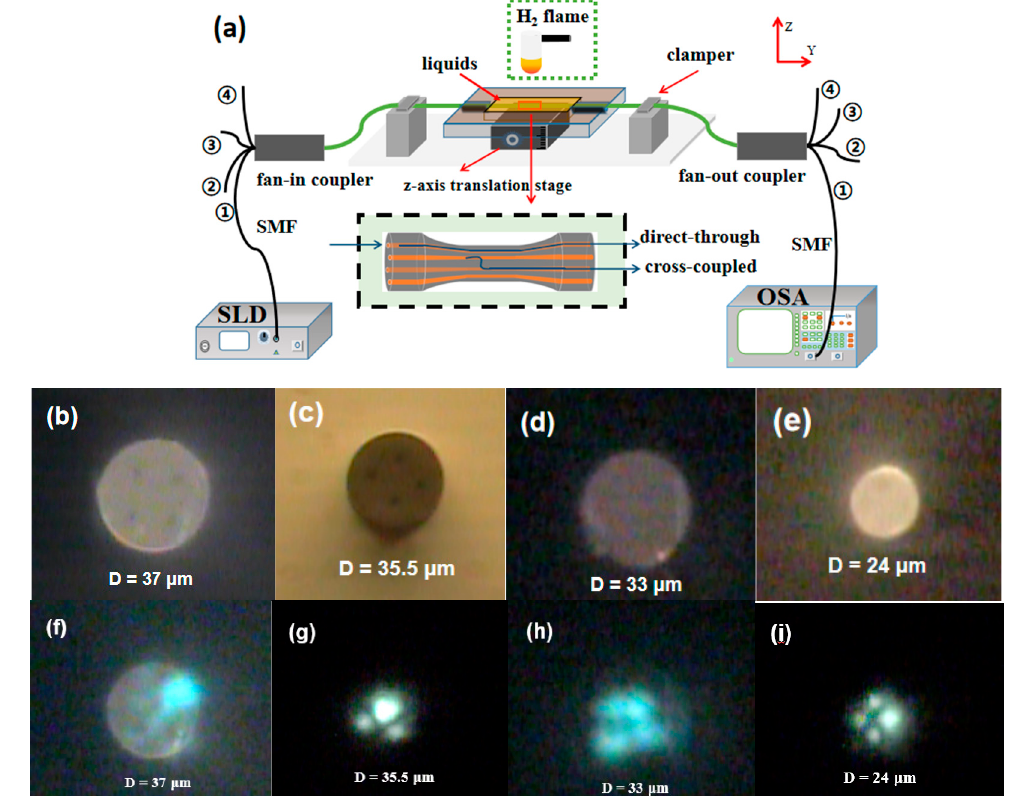
Figure 2. ( a ) Experimental set-up for fabricating TFCF RI sensors based on the vertex-core excitation scheme. Cross-sectional views of the microphotographs of the TFCF when ( b ) D = 37 μ m, ( c ) D = 35.5 μ m, ( d ) D = 33 μ m and ( e ) D = 24 μ m under a 1000× CCD microscope. ( f ) Vertex-core excitation scheme (D = 37 μ m). Far-field mode patterns of the excited supermodes for the ( g ) tri-core structure (D = 35.5 μ m), ( h ) quadruple-core structure (D = 33 μ m) and ( i ) quadruple-core structure (D = 24 μ m).